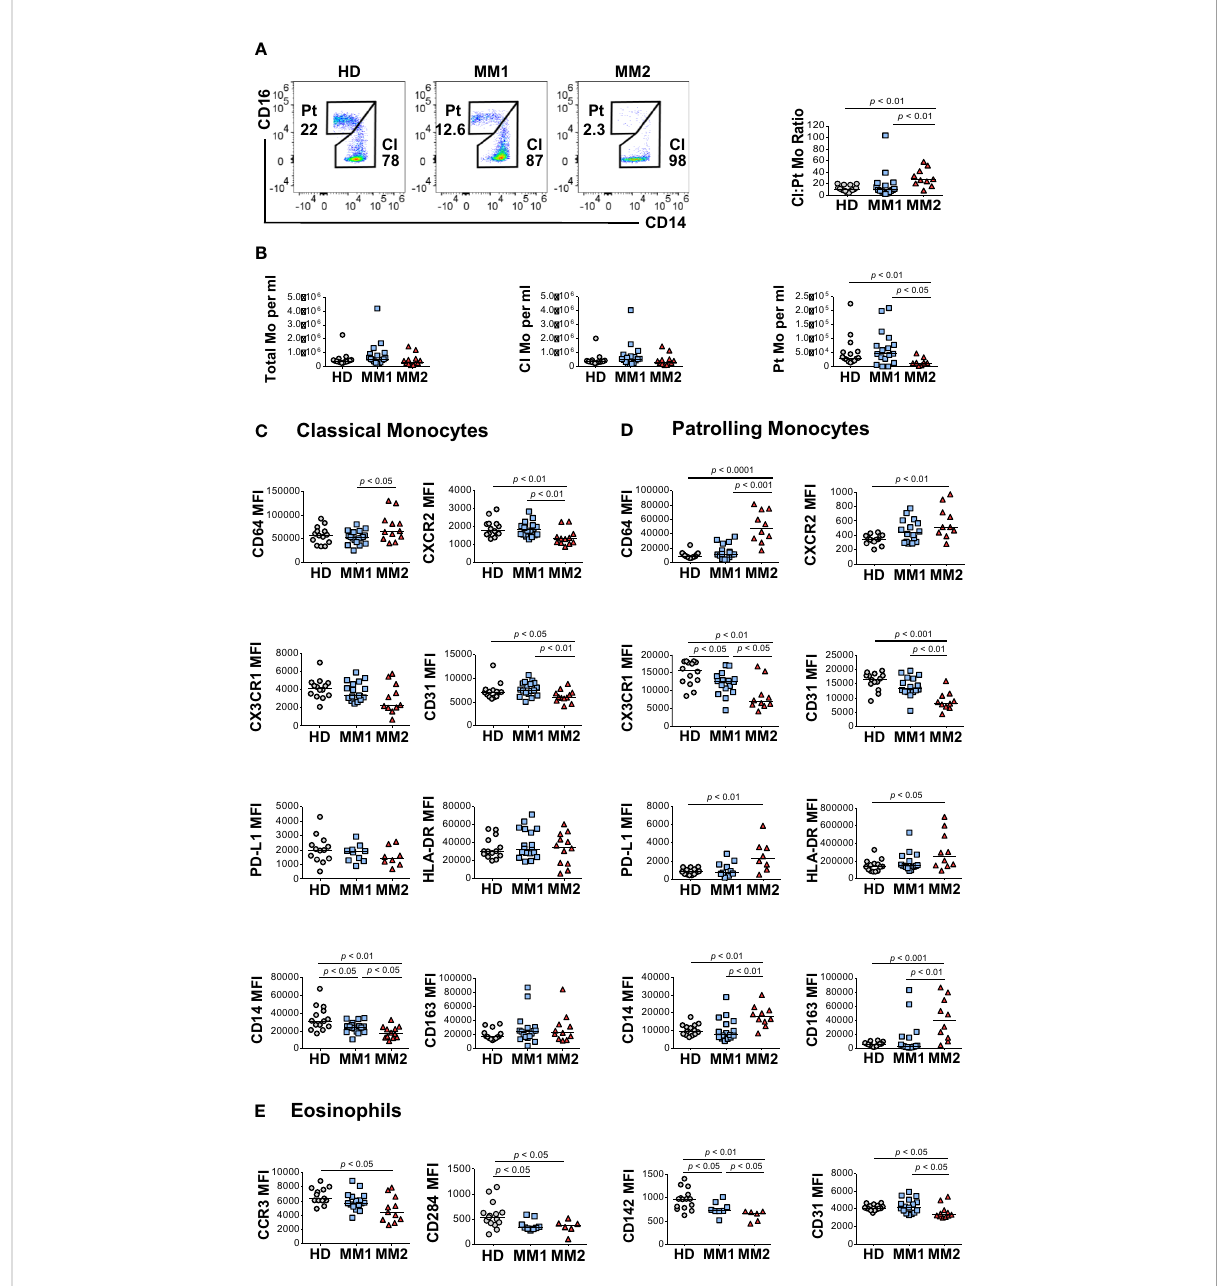
FIGURE 3 Altered monocytic and eosinophilic phenotypes in MM2 patients. (A) Left panel: representative cytograms of CD16 low CD14 high classical monocytes (Cl Mo) and CD16 high CD14 low patrolling monocytes (Pt Mo) in whole blood from HD, MM1 and MM2 patients. Right panel: classical to patrolling monocyte ratios from HD, ( n =15) MM1, ( n =16) and MM2 ( n =10) patients. (B) Frequencies of total, classical, and patrolling monocytes. (C, D) Surface levels of monocyte markers on classical (C) or patrolling monocytes (D) . (E) Surface levels of eosinophil markers of HD, MM1, and MM2 patients. MFI, median fl uorescent intensity; statistical analyses were performed using the Mann-Whitney rank-sum test with p values indicated. Bars represent median